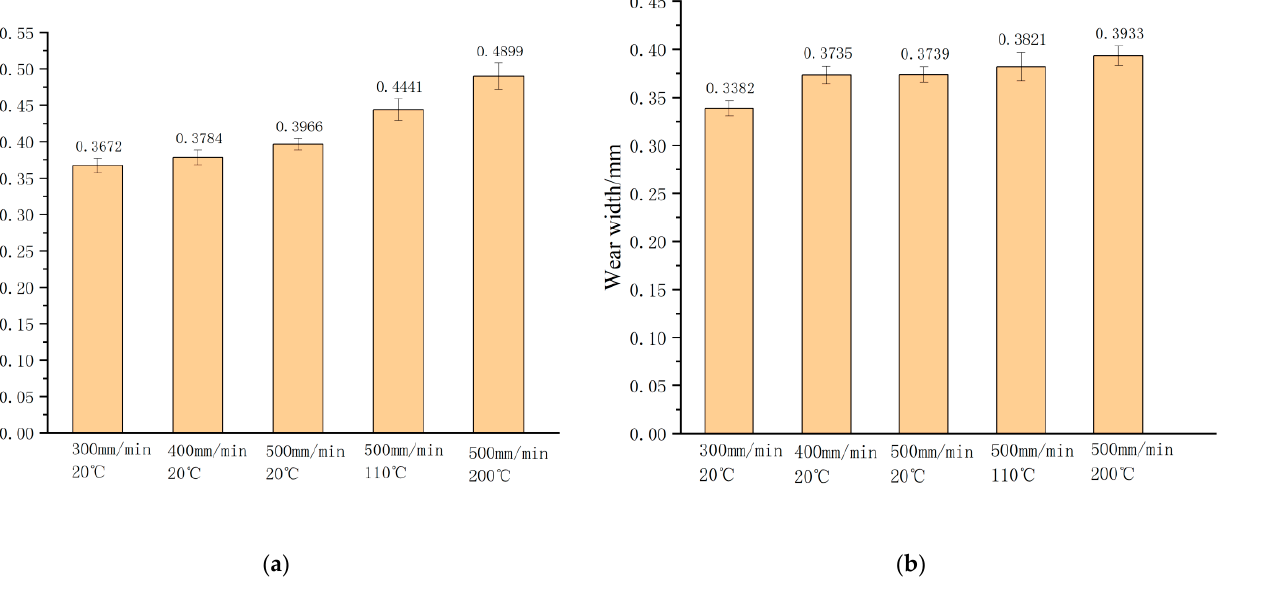
increase, and the bottom of the steel ball would gradually ground. Under the action of vertical force, the contact width between the surface of the laser-strengthened 40CrNiMo